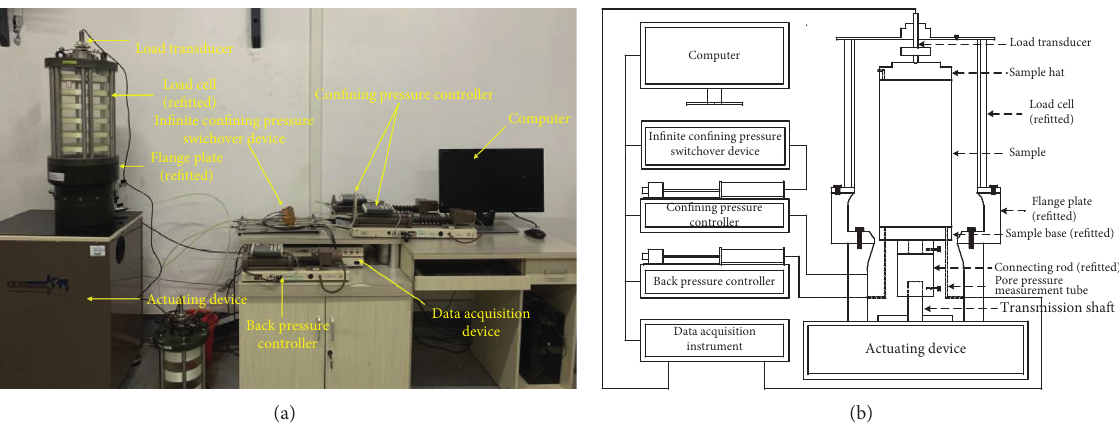
Figure 3: GDS triaxial test apparatus in (a) photo and (b)